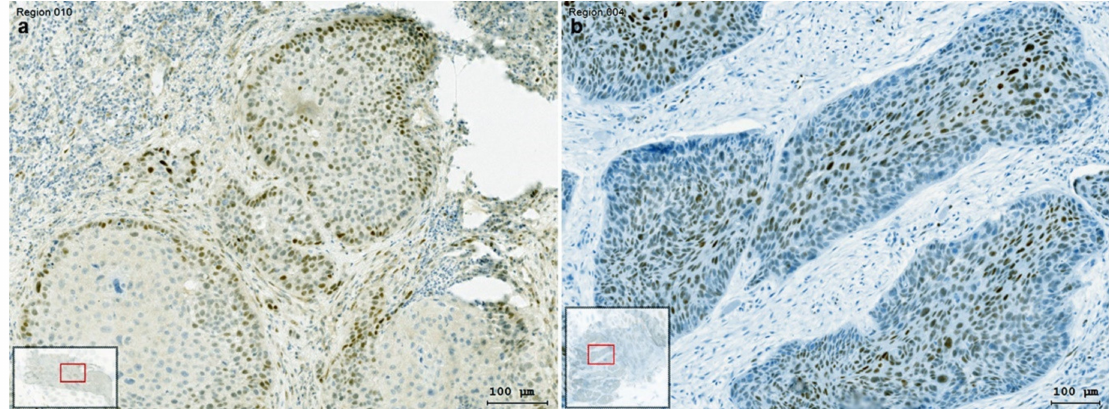
Figure 10. Enzyme immunohistochemistry for Slug ( a ), and KLF4 ( b ) in HNSCC tumor tissue. Staining differences between the core and the border of the tumor cell nest were analyzed by TissueFax ® (Tissuegnostics TM ). Slug IHC reaction was detected at the border of the tumor cell nest ( a ). The tumor cell nest boundary showed a drastic decline or loss of the epithelial marker KLF4 in Slug positive HNSCC tumor tissue samples ( b ). The decreasing gradient of KLF4 from the middle to the border of the tumor cell nest ( b ), was presented together with the increasing gradient of the nuclear reaction of Slug, localized at the border of the tumor cell nest ( a